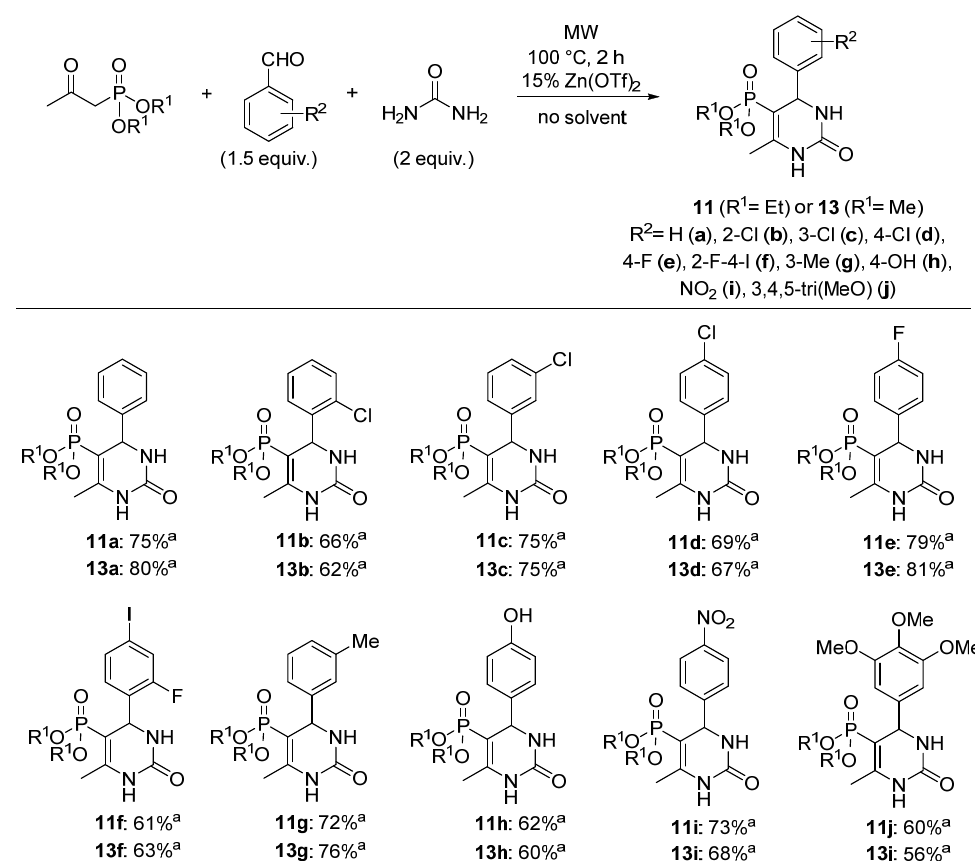
Scheme 5. Biginelli reaction of diethyl or dimethyl (2-oxopropyl)phosphonate, substituted benzaldehydes and